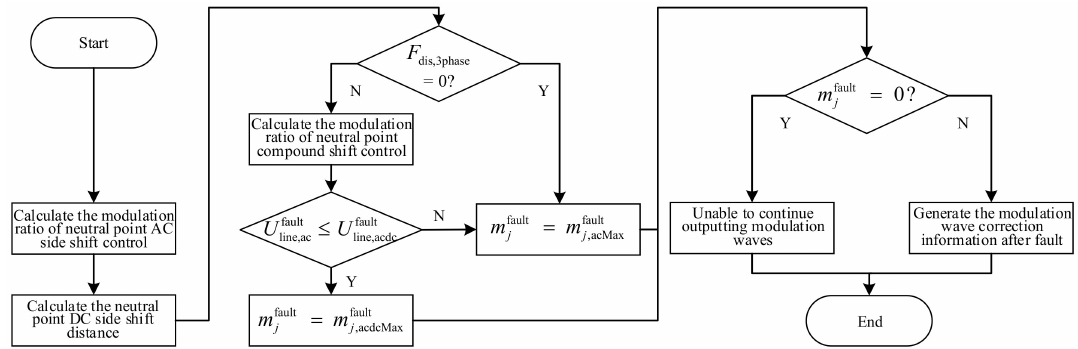
Figure 8. The overall flowchart of fault-tolerant control.